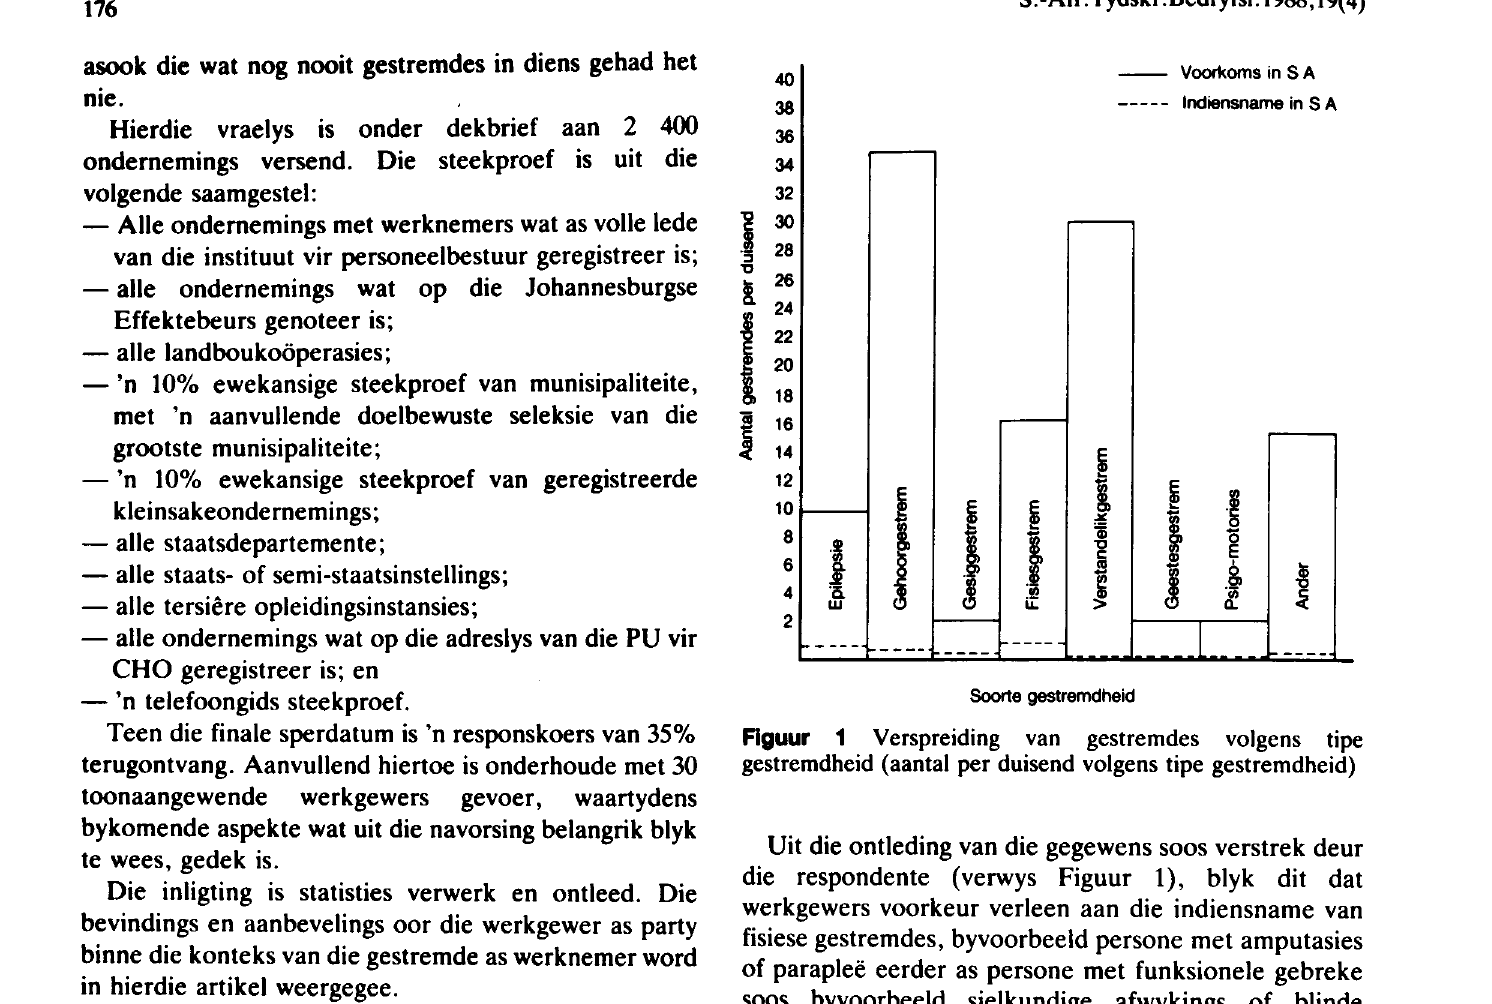
blindes. Die gemeenskap kan sodoende baat omdat die gestremde 'n produktiewe lid van die samelewing